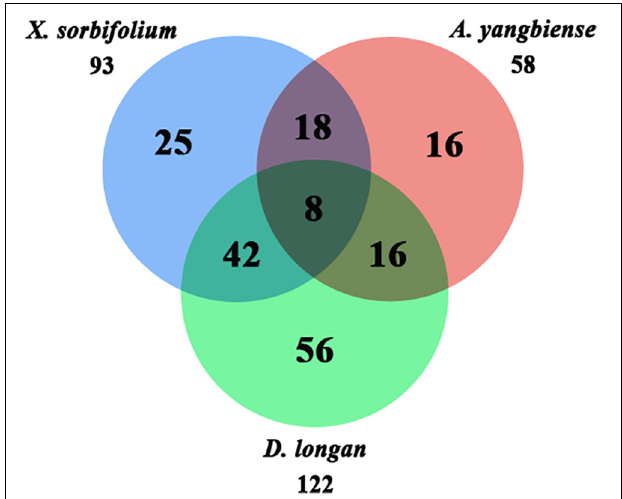
FIGURE 3 | Ancestral Sapindaceae linage genes in the X. sorbifolium , A. yangbiense , and D. longan genomes.